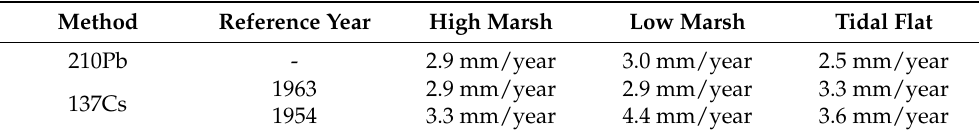
Figure A3. Profiles of the 210 Pb total activity ( A ), the Ln 210 Pb excess activity ( B ), and 137 Cs activity ( C ) of the tidal flat core. Table A3. Sedimentation rates derived from 210 Pb and 137 Cs data for each sediment core.